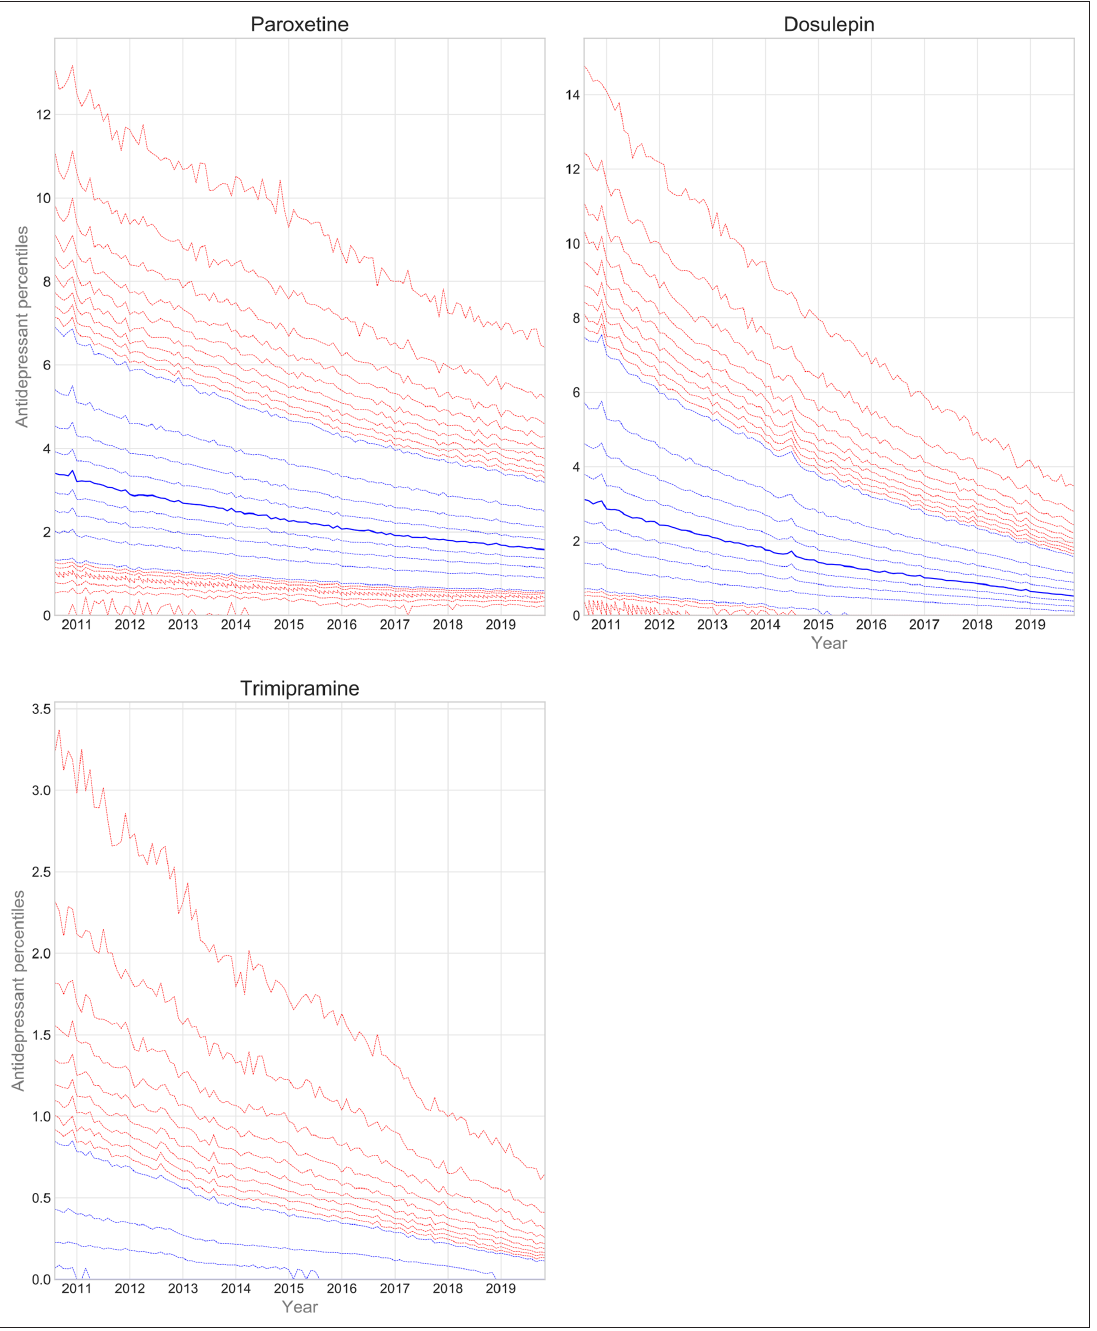
Figure 5 Practice- level percentile charts for the proportions of paroxetine, dosulepin, and trimipramine prescribed out of all antidepressant items, from August 2010–November 2019. Deciles are in blue, with median shown as a heavy blue line, and extreme percentiles are in